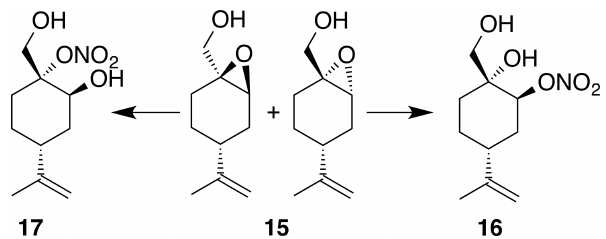
Figure 6. Nitration of perillic alcohol